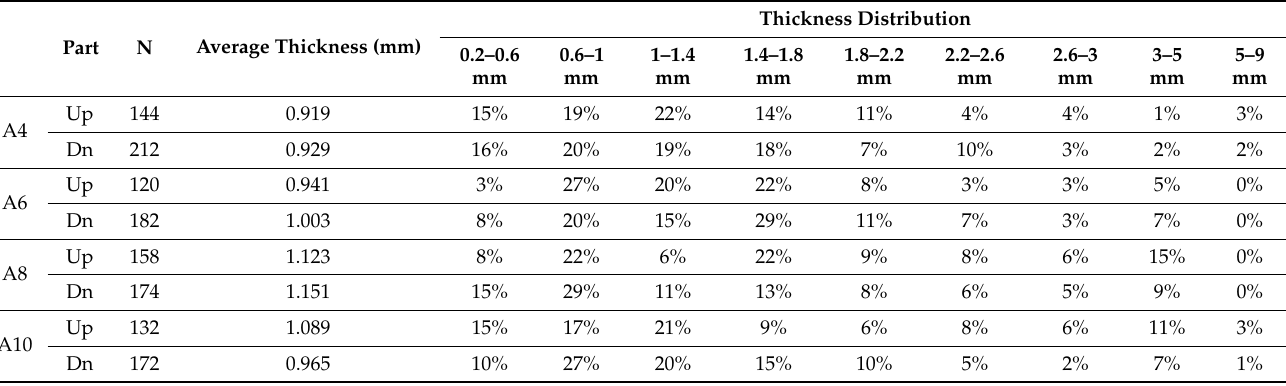
Table 5. Thickness of paste on the surface of